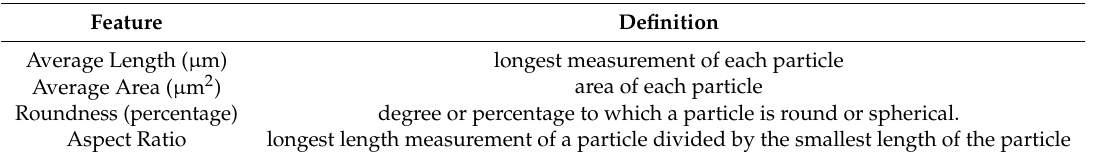
Table 2. Definition of the Si particles used in the present